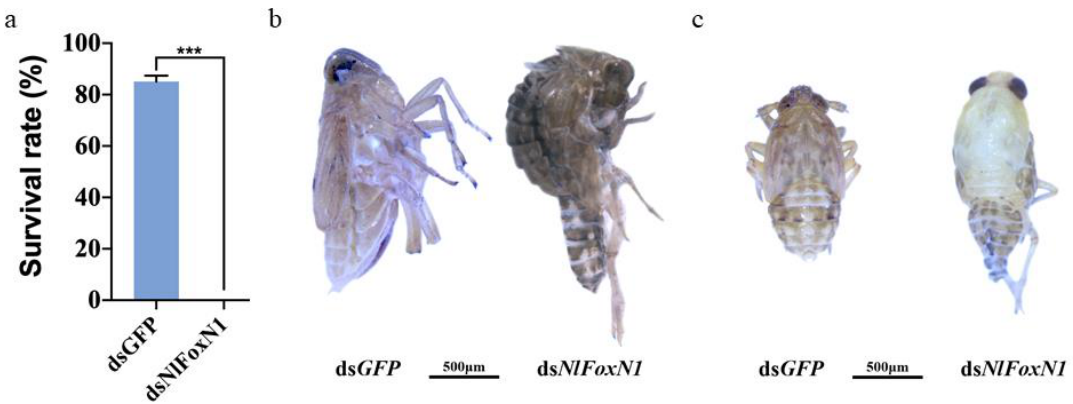
Figure 4. Knockdown of NlFoxN1 in nymphs a ff ected the molting process. ( a ) The survival rate after NlFoxN1 -RNAi in the fifth instar. ( b,c ) The lethal phenotypes after injection of dsRNA for NlFoxN1 in the fifth instar ( b ) and the fourth instar ( c ). dsRNA (50 ng per insect; n = 100) was injected into BPHs at the very beginning of each instar. ds GFP was injected as a negative control for the nonspecific e ff ects of dsRNA. Mean ± s.e.m. from three experiments. *** p < 0.001 (Student’s t -test), di ff erence from ds GFP